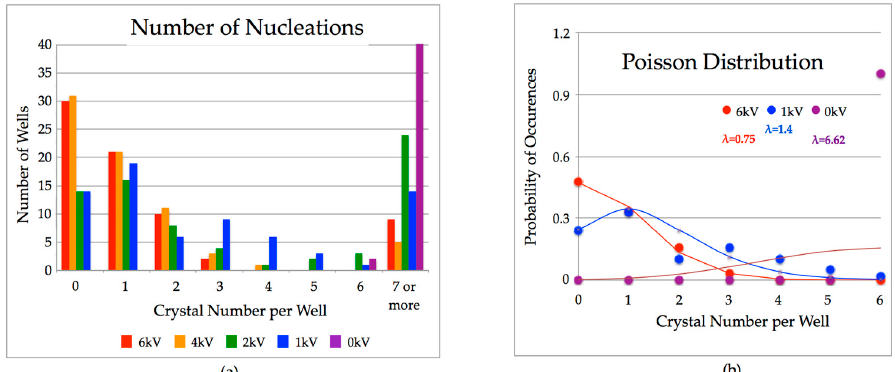
Figure 1. Distribution of the number of Glucose Isomerase crystals grown by the microbatch method in the presence of an external DC electric field for 48 h. In total, 360 microbatch wells were probed. ( a ) Number of nucleation sites for the five voltages probed; ( b ) Poisson distribution of the number of crystals per well indicates that the optimal electric field for crystallization of Glucose Isomerase lies around 5 kV.